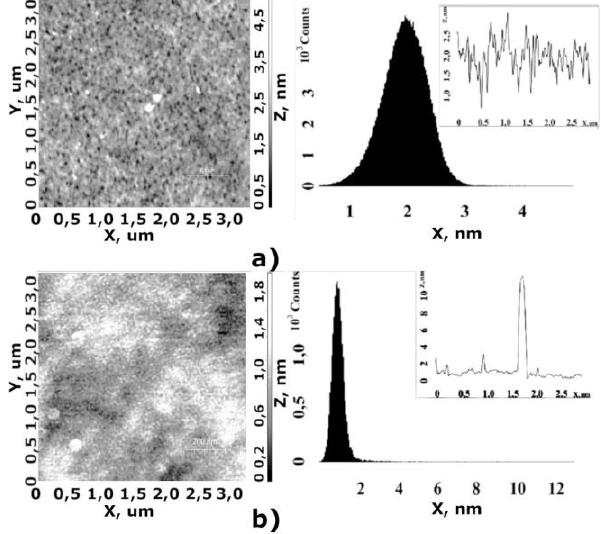
Fig. 2. Morphology, distribution of heights and revealed characteristic profilogram for: а) 3nm; b)